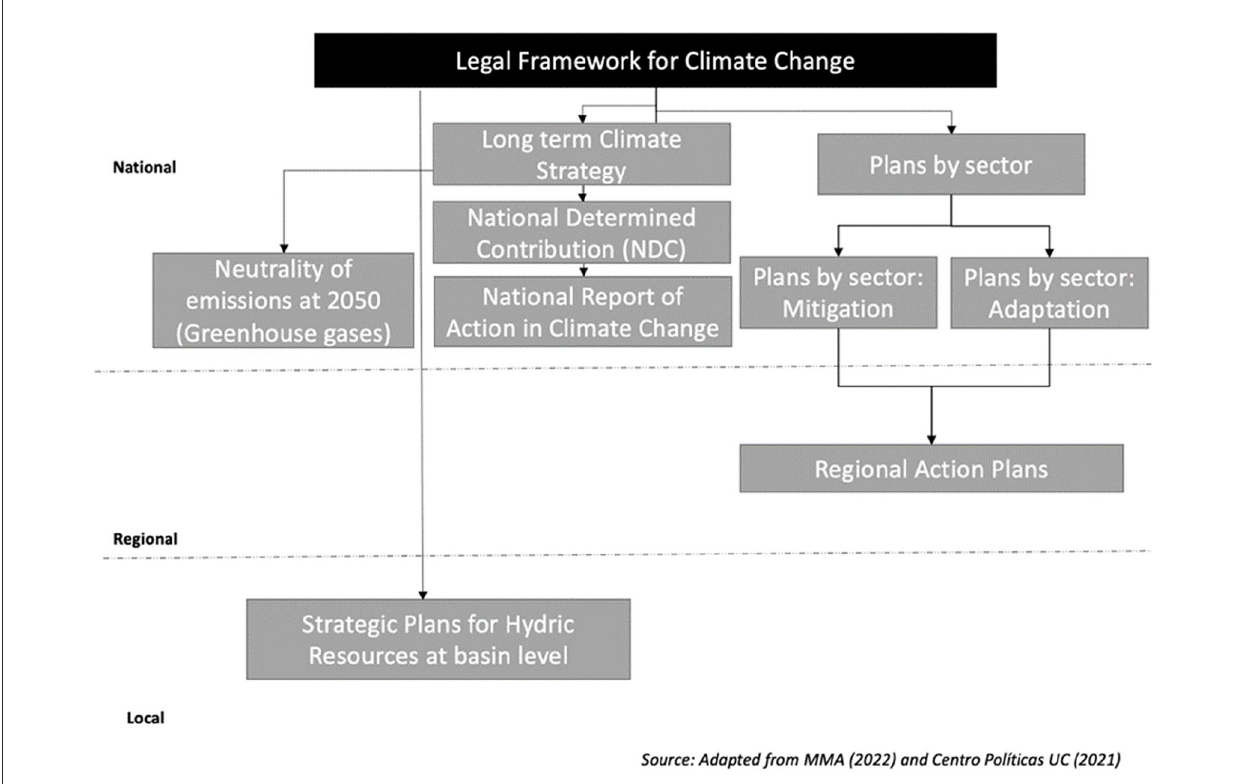
FIGURE1 A diagram showing the linkage between various instruments and public policies related to climate change established by the Chilean Ministry of Environment. Source: Adapted from Centro UC de Políticas Públicas (2021), Ministerio del Medio Ambiente (MMA)